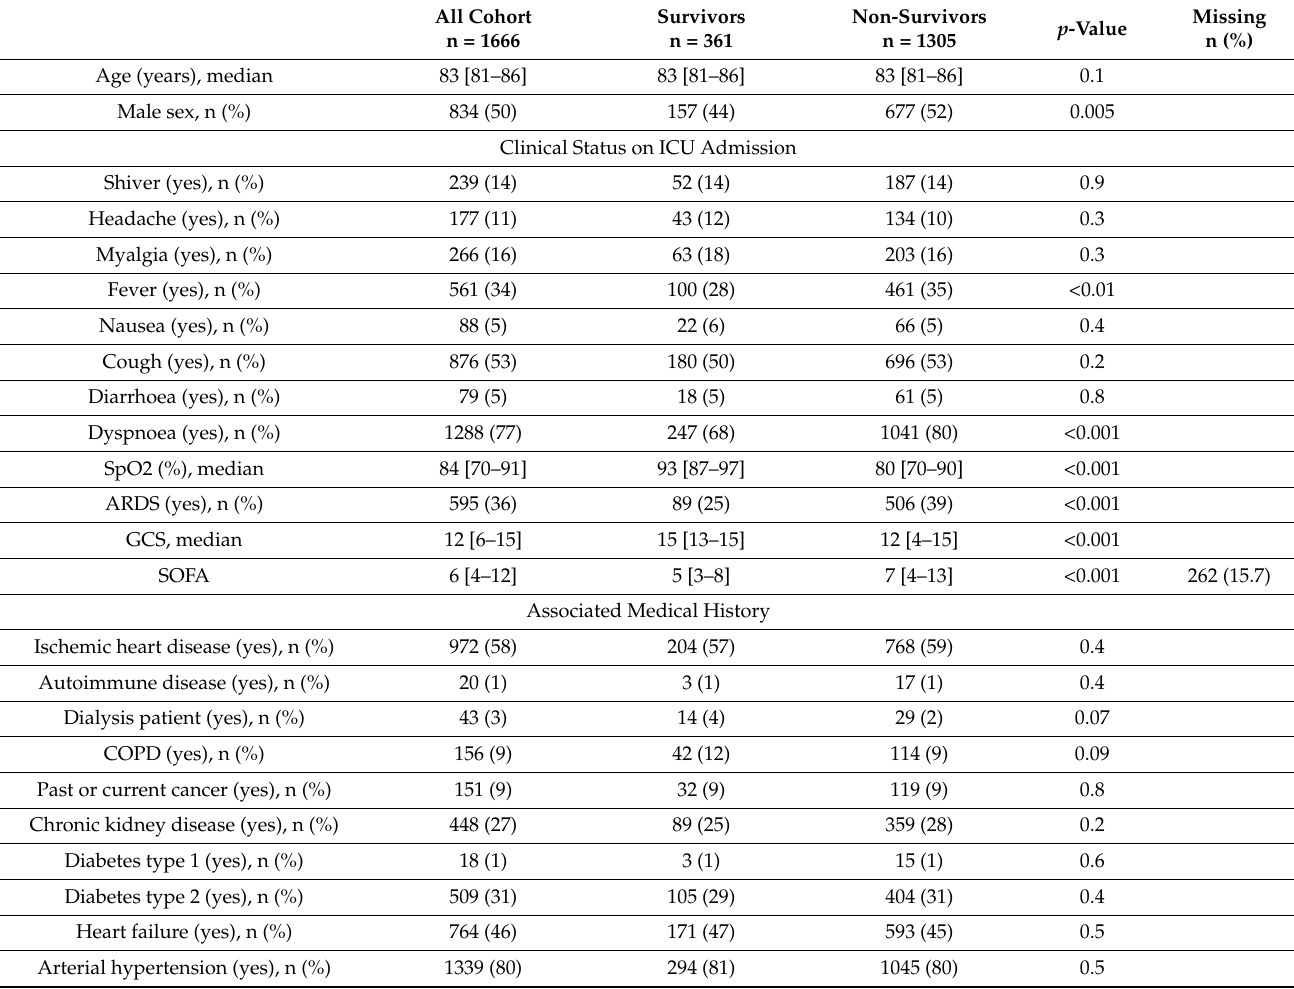
Table 1. Patients’ characteristics at ICU